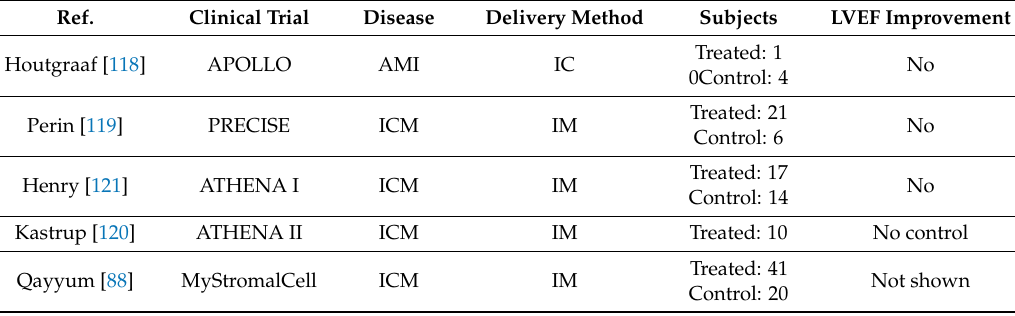
Table 6. Clinical trials with ADSCs for cardiac regeneration.